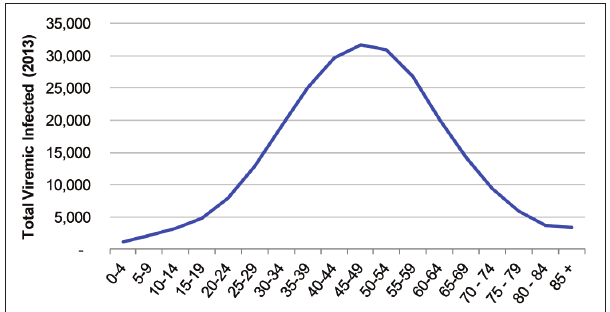
Figure 4) Total number of viremic hepatitis C cases cases according to age, 2013